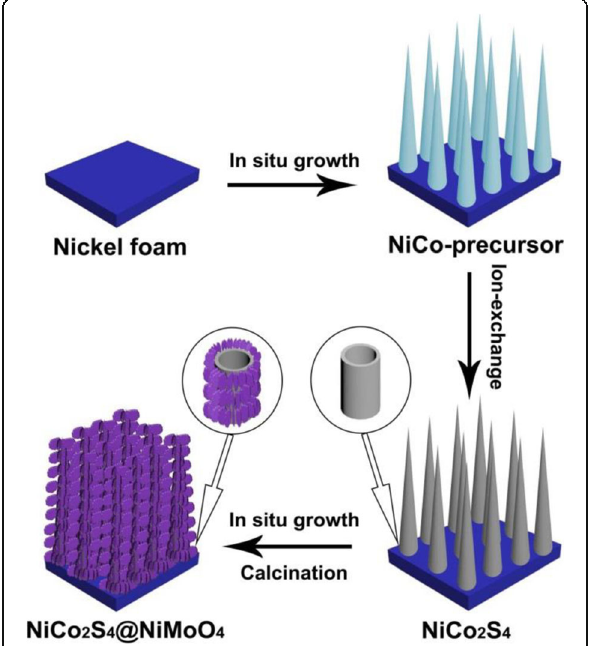
Fig. 1 Schematic fabrication process of NiCo 2 S 4 @NiMoO 4 /NF